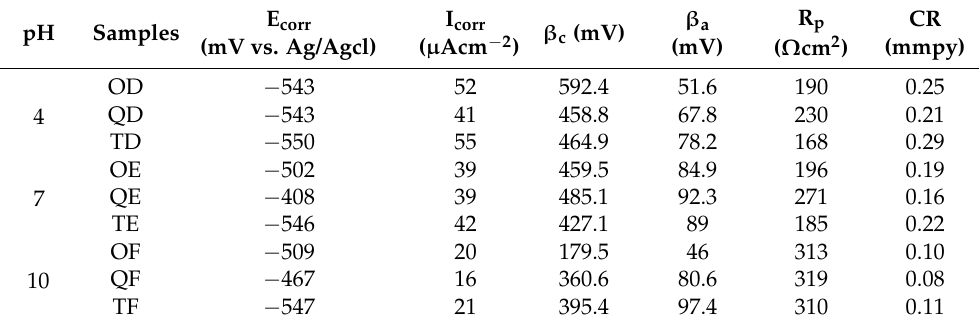
Table 7. Dynamic polarization data for O, Q, and T samples at pH 4, 7, and 10 in Cl − free